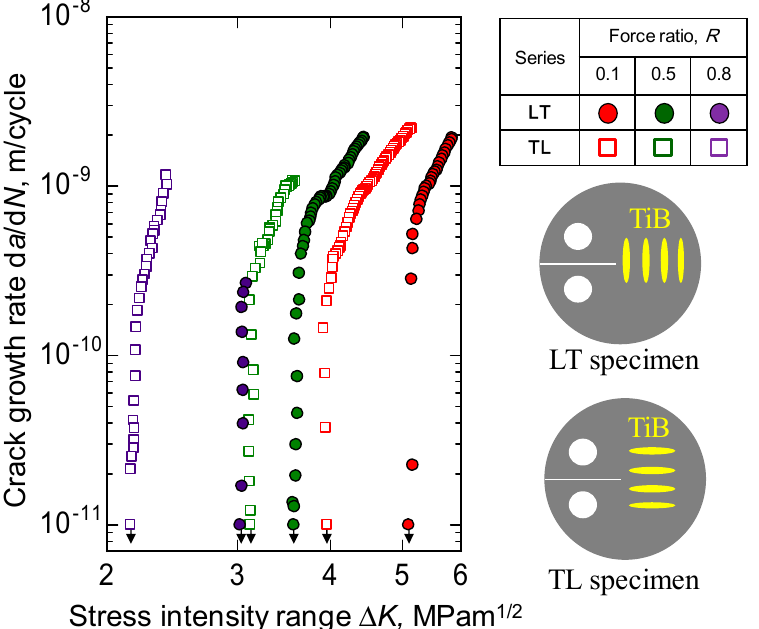
Figure 4. Relationship between crack growth rate and stress intensity range for TiB / Ti-3Al-2.5V composites having di ff erent TiB orientations.